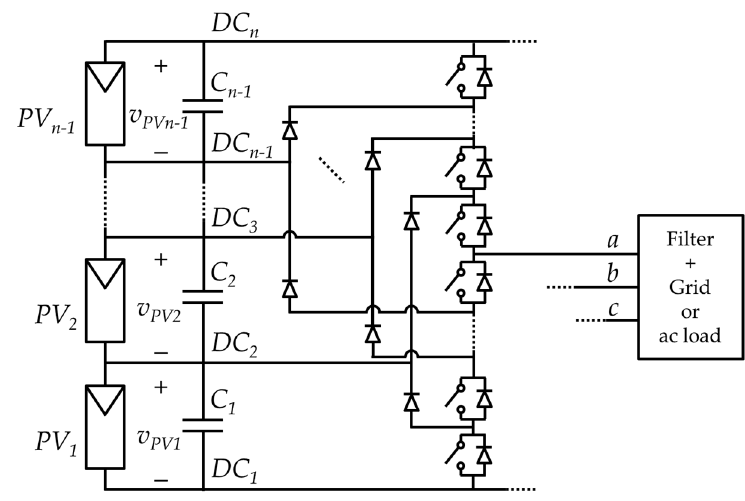
Figure 18. Connection of ( n − 1 ) series-connected photovoltaic arrays to the grid (or AC load) through a n -level three-phase NPC inverter.